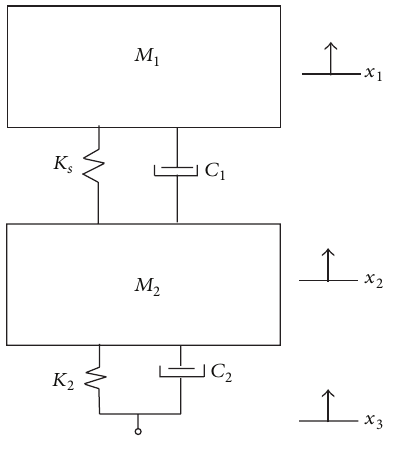
Figure 3: The 2-DOF damping